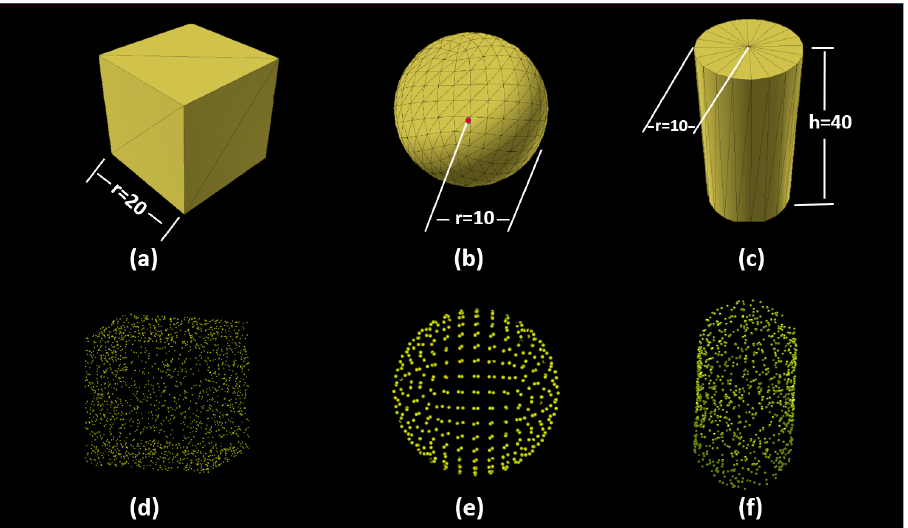
Figure 1. Regular shape objects and corresponding point clouds. ( a ) The cube model; ( b ) the sphere model; ( c ) the cylinder model; ( d ) the point cloud resampled the cube model; ( e ) the point cloud consisted of the original mesh vertices in the sphere model; ( f ) the point cloud resampled the cylinder model.